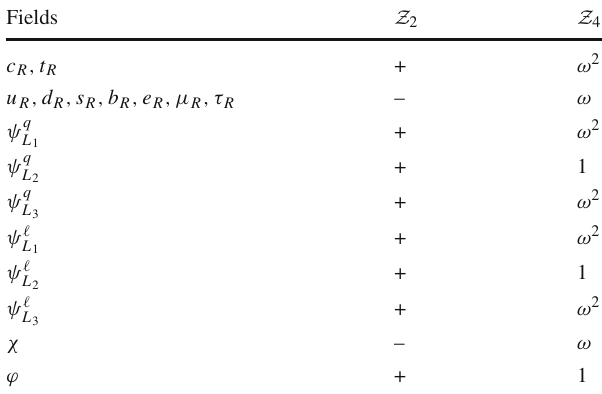
Table2 Thechargesofleftandright-handedfermionsofthreefamilies of the SM, Higgs and the flavon fields under the Z 2 and Z 3 product symmetry, where ω is the cube root of unity Fields Z 2 Z 3